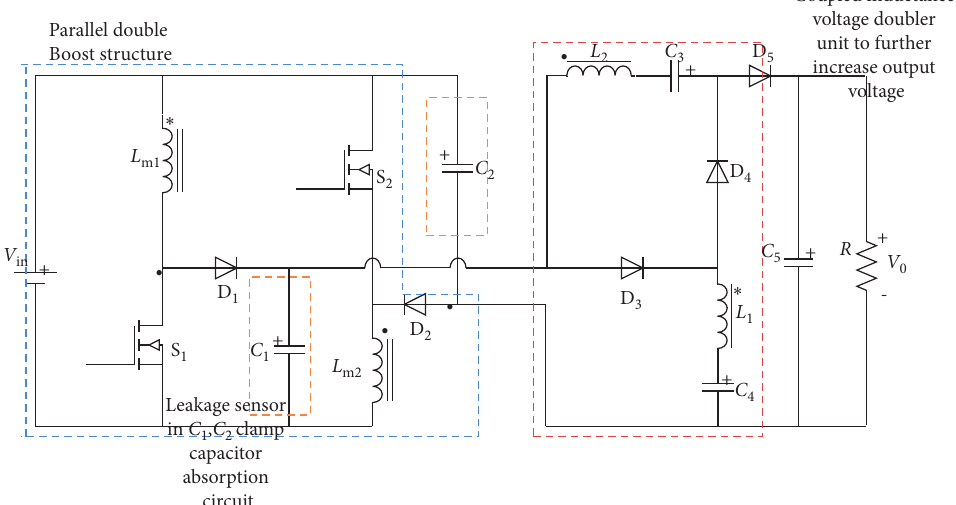
Figure 2: Double-boost combined converter with the double-voltage coupled inductor.